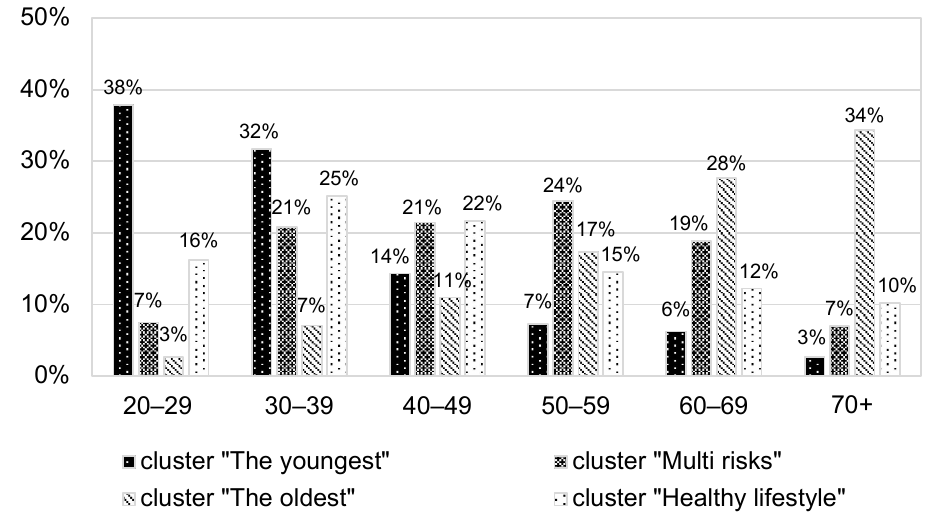
Figure 2. The age structure of identified clusters members.